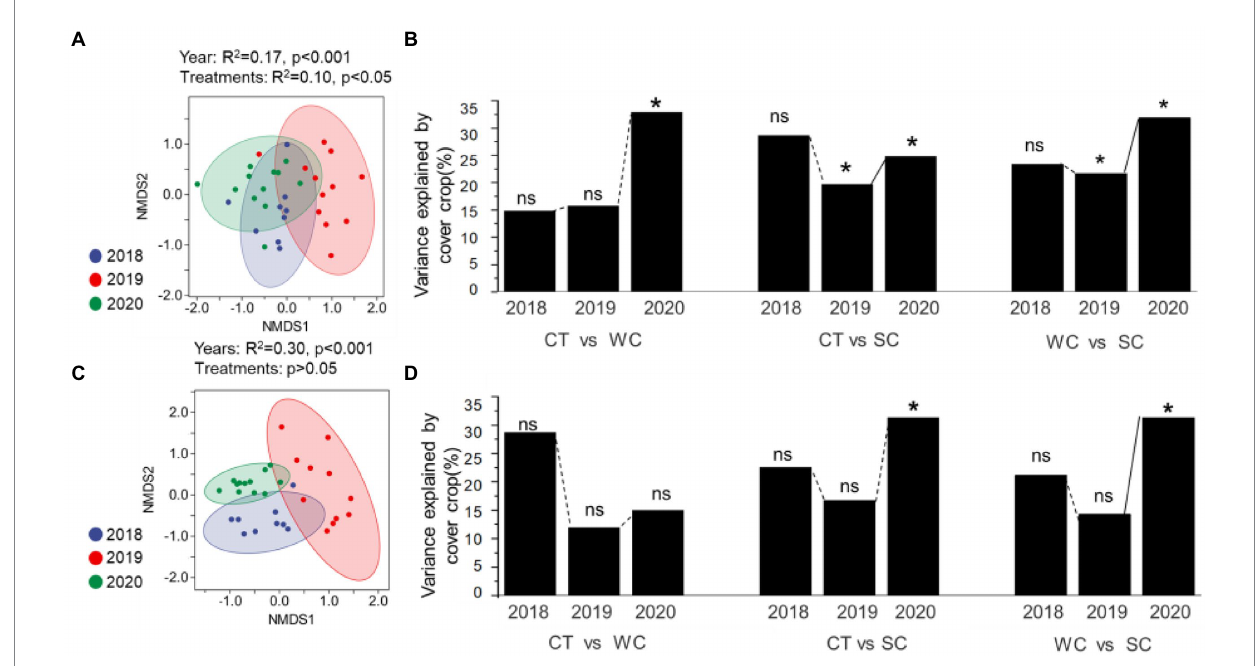
FIGURE 3 Soil fungal community composition variation over years with conventional tillage (CT), weed cover (WC), and Siratro cover (SC) treatments. NMDS and PERMANOVA analysis of the intercropping area ( A , B , respectively), and furrow ( C , D , respectively). *Indicates significance at p ≤ 0.05, and ns indicates not